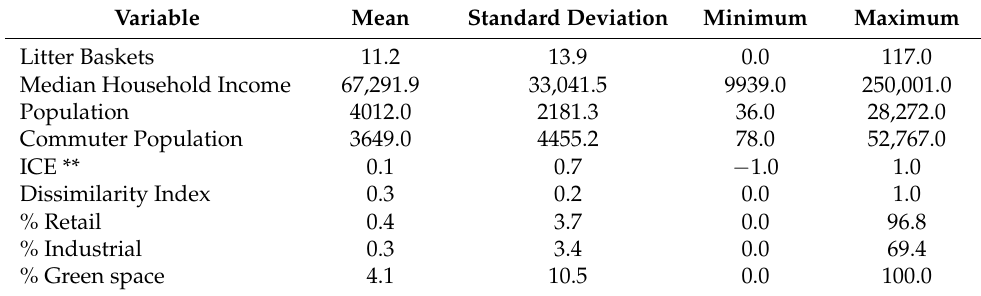
Table 1. Descriptive statistics for 2101 census tracts in New York City *.